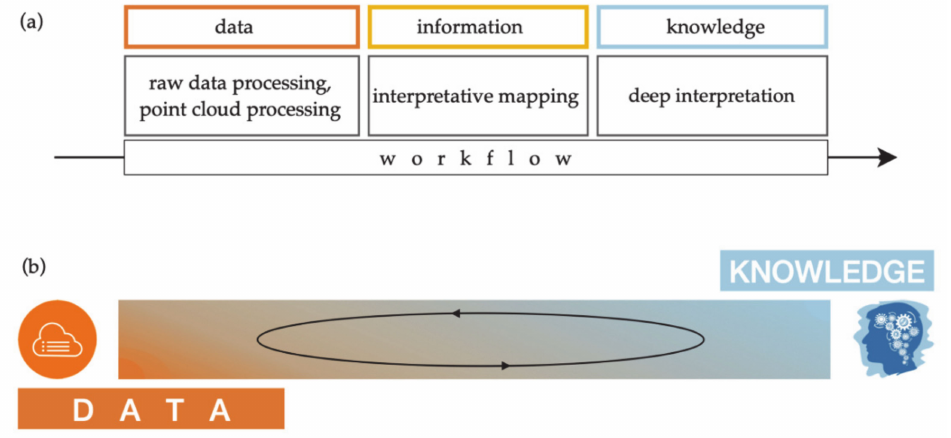
Figure 18. Schematic overview of the archaeology-specific knowledge production process based on airborne LiDAR data: ( a )—“rigid” binary approach; ( b )—fuzzy approach (“data” and “knowledge” icons by Vecteezy.com published under CC-BY